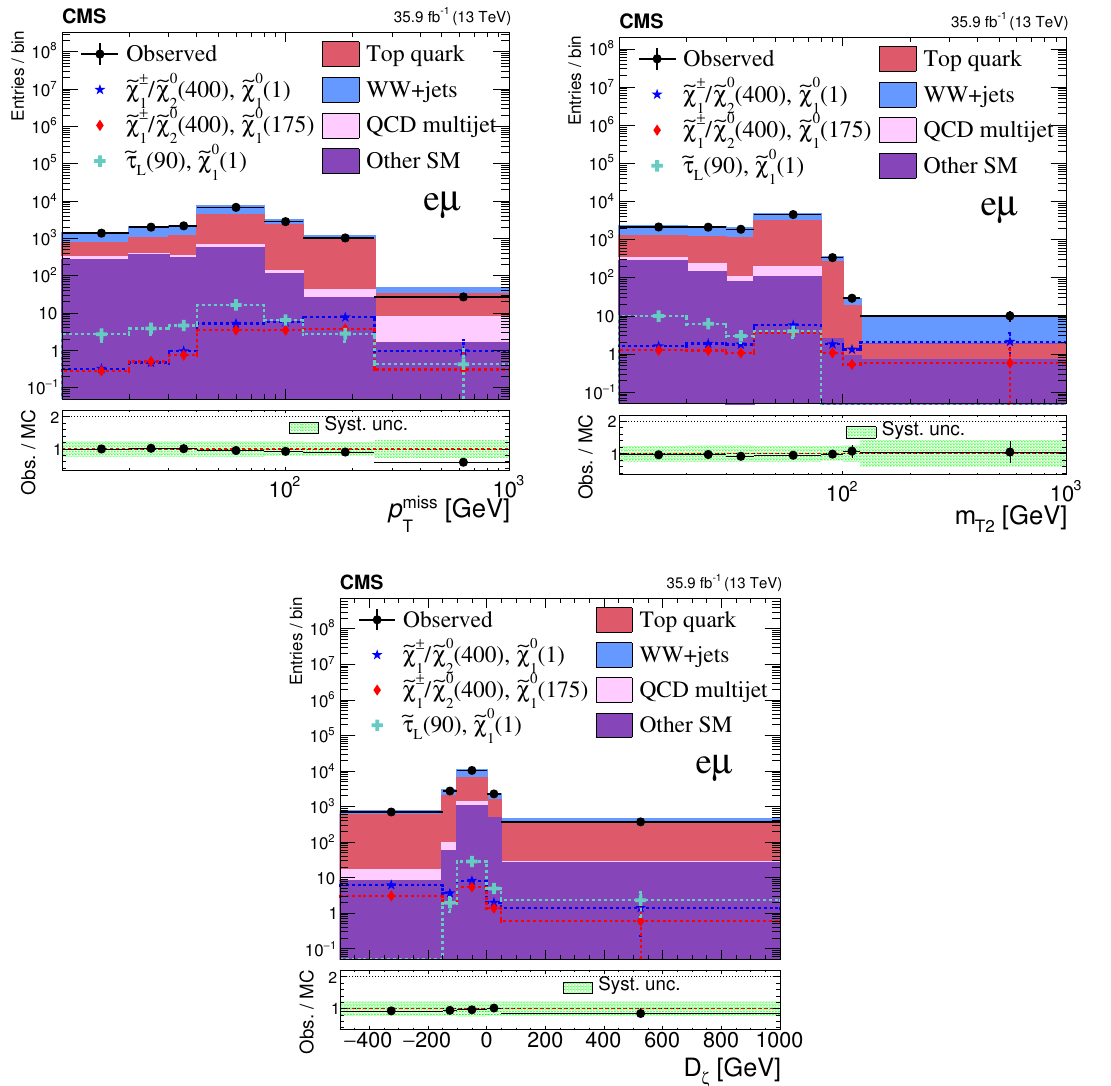
Figure 7. Distributions of the search variables p miss (top left), m T2 (top right), and D (cid:16) (bottom) T for the e (cid:22) (cid:12)nal state for events after the baseline selection. The black points show the data. The background estimates are represented with stacked histograms. Distributions for two benchmark models of chargino-neutralino production, and one of direct left-handed (cid:28) pair production, are overlaid. The numbers within parentheses in the legend correspond to the masses of the parent SUSY particle and the (cid:31) 0 in GeV for these benchmark models. In all cases, the last bin includes e 1 e